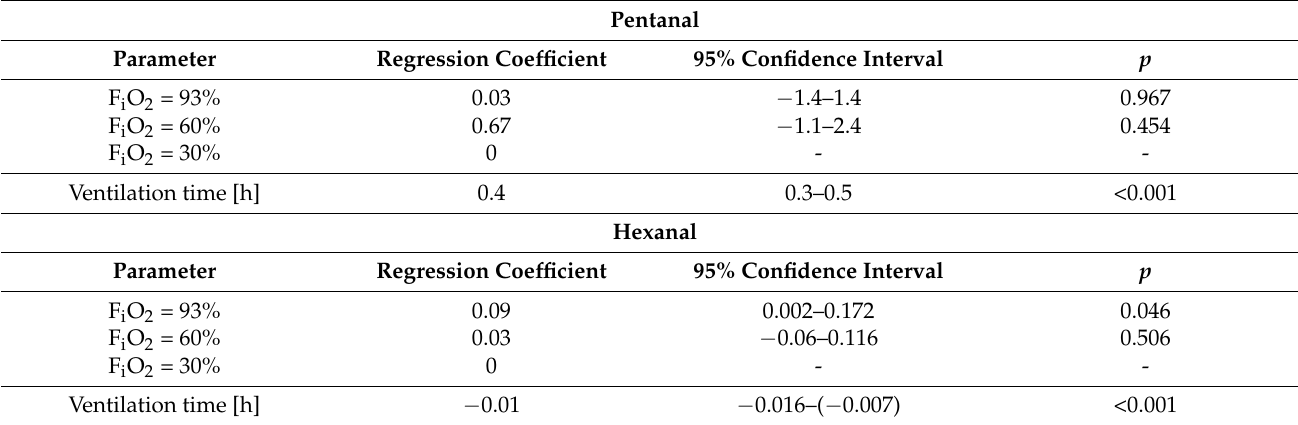
Linear generalized estimating equations (GEE)—regression was performed. The regression coefficient of ventilation time refers to one hour of mechanical ventilation. F i O 2 = fraction of inspired oxygen.